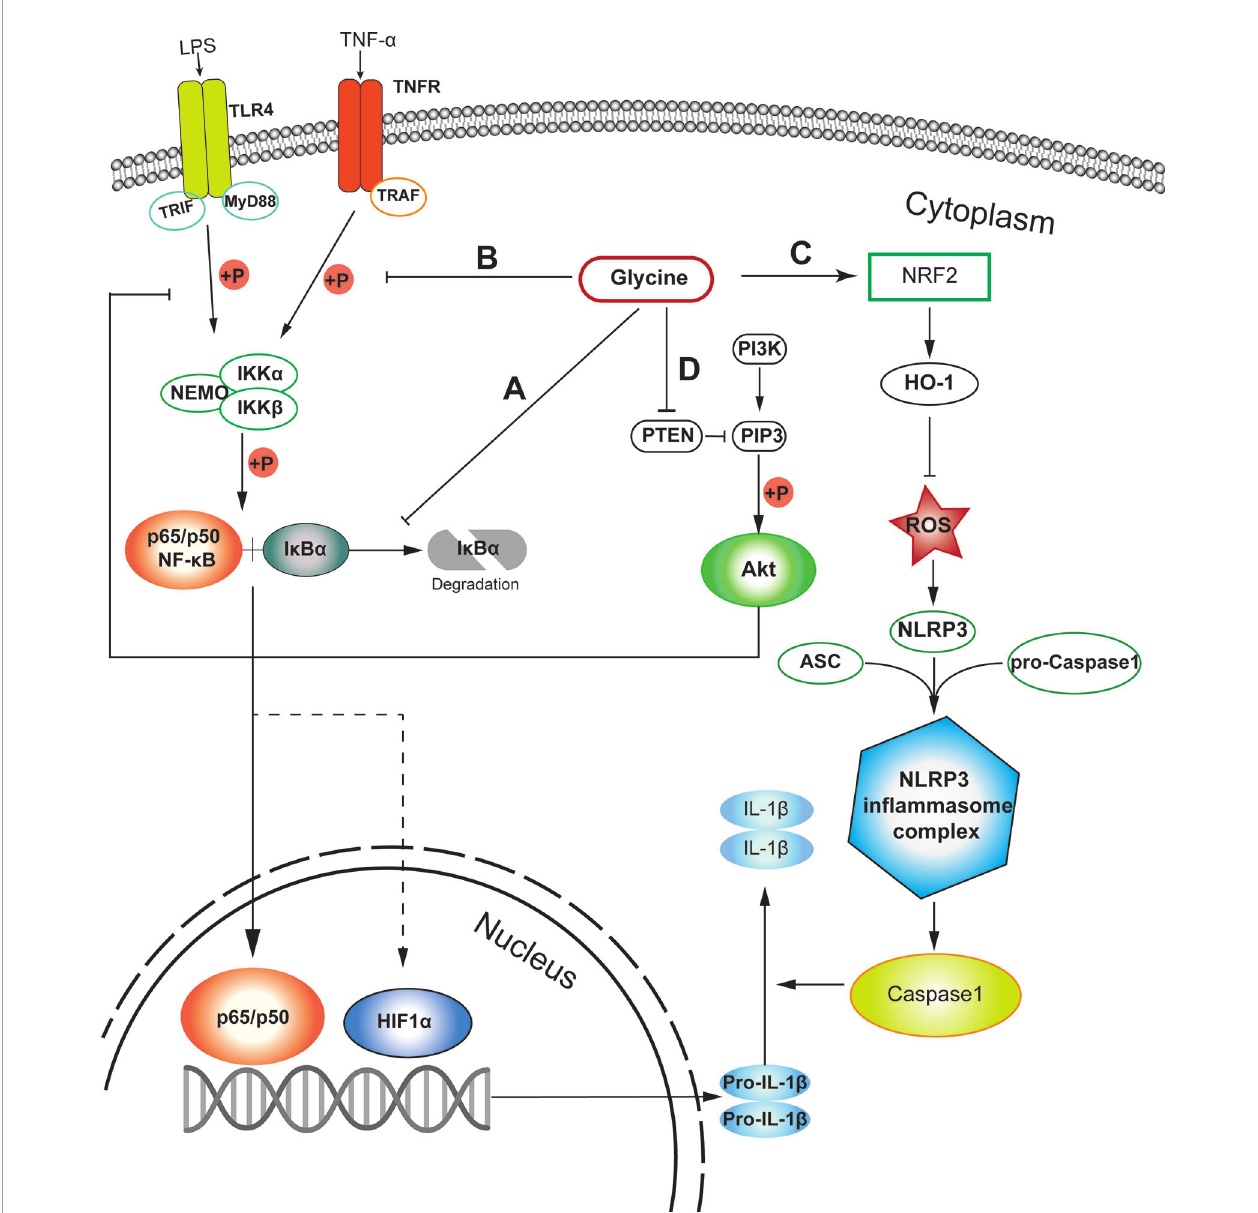
FIGURE 1 | Probable cellular pathways that glycine in fl uences M1 macrophages polarization. (A) Glycine inhibits the degradation of I k B in M1-macrophages. (B) Glycine inhibits M1-macrophages polarization via inhibiting IKK phosphorylation. (C) Glycine up-regulates NRF-2/HO-1 to blunt NLRP3 in in fl ammasome in M1- macrophages. (D) Glycine inhibits NF- k B by blocking PTEN to up-regulate Akt in M1-macrophages. LPS, lipopolysaccharide; TLR4, toll-like receptor 4; MyD88, myeloid differentiation primary response gene 88; NF- k B, nuclear factor kappa-light-chain-enhancer of activated B cells; I k B, inhibitor of NF- k B; IKK, I k B kinase; TNF- a , tumor necrosis alpha; TNFR, TNF- a receptor; TRAF, TNFR associated factor; PTEN, phosphatase and tensin homolog deleted on chromosome ten; PIP3, phosphatidylinositol (3,4,5)-trisphosphate; Akt, protein kinase